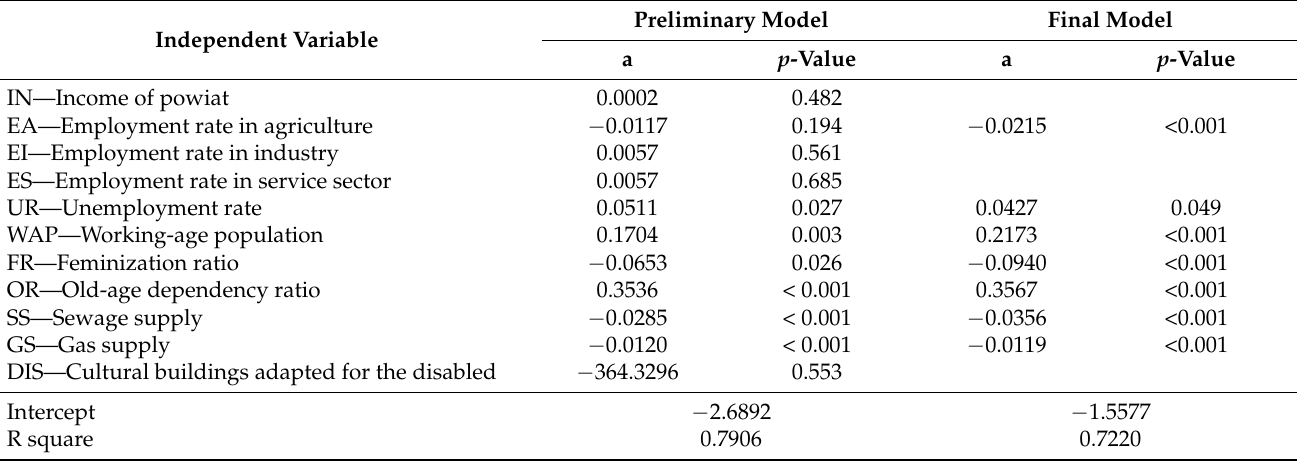
Table 8. Parameters of the regression